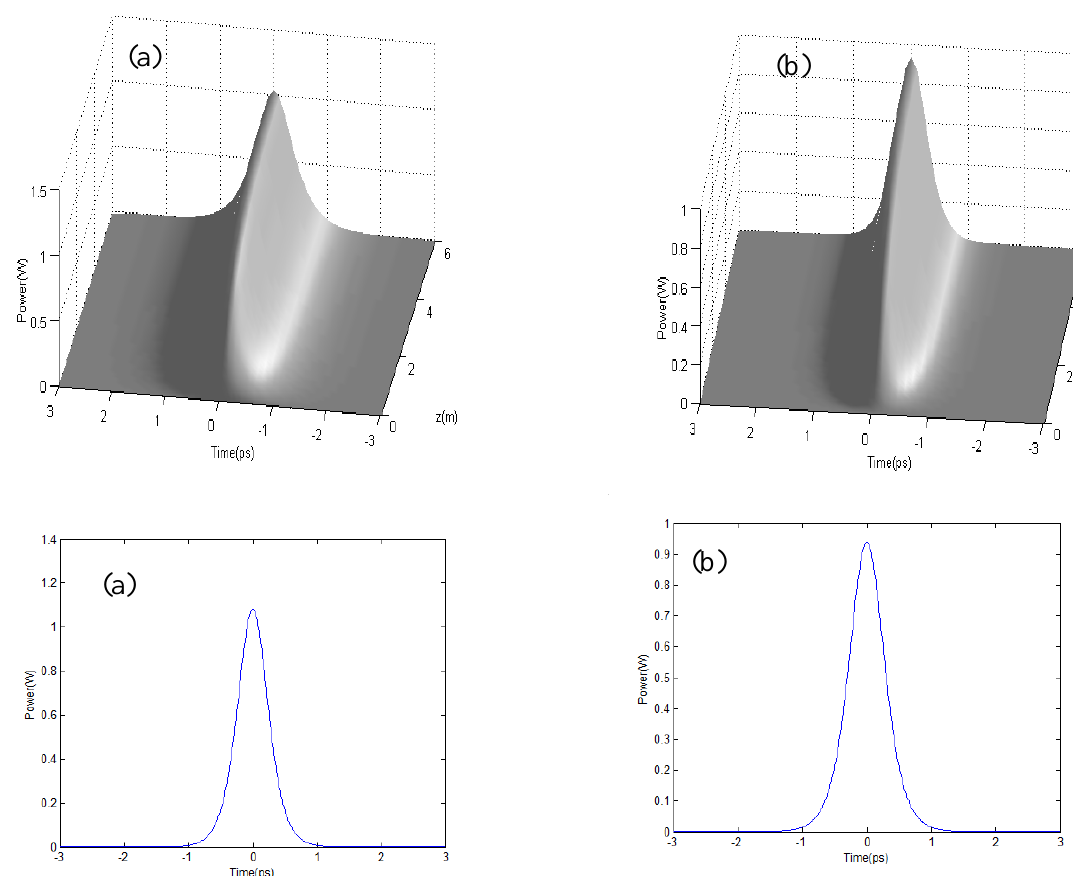
Fig.10: Soliton width for (a) (b)